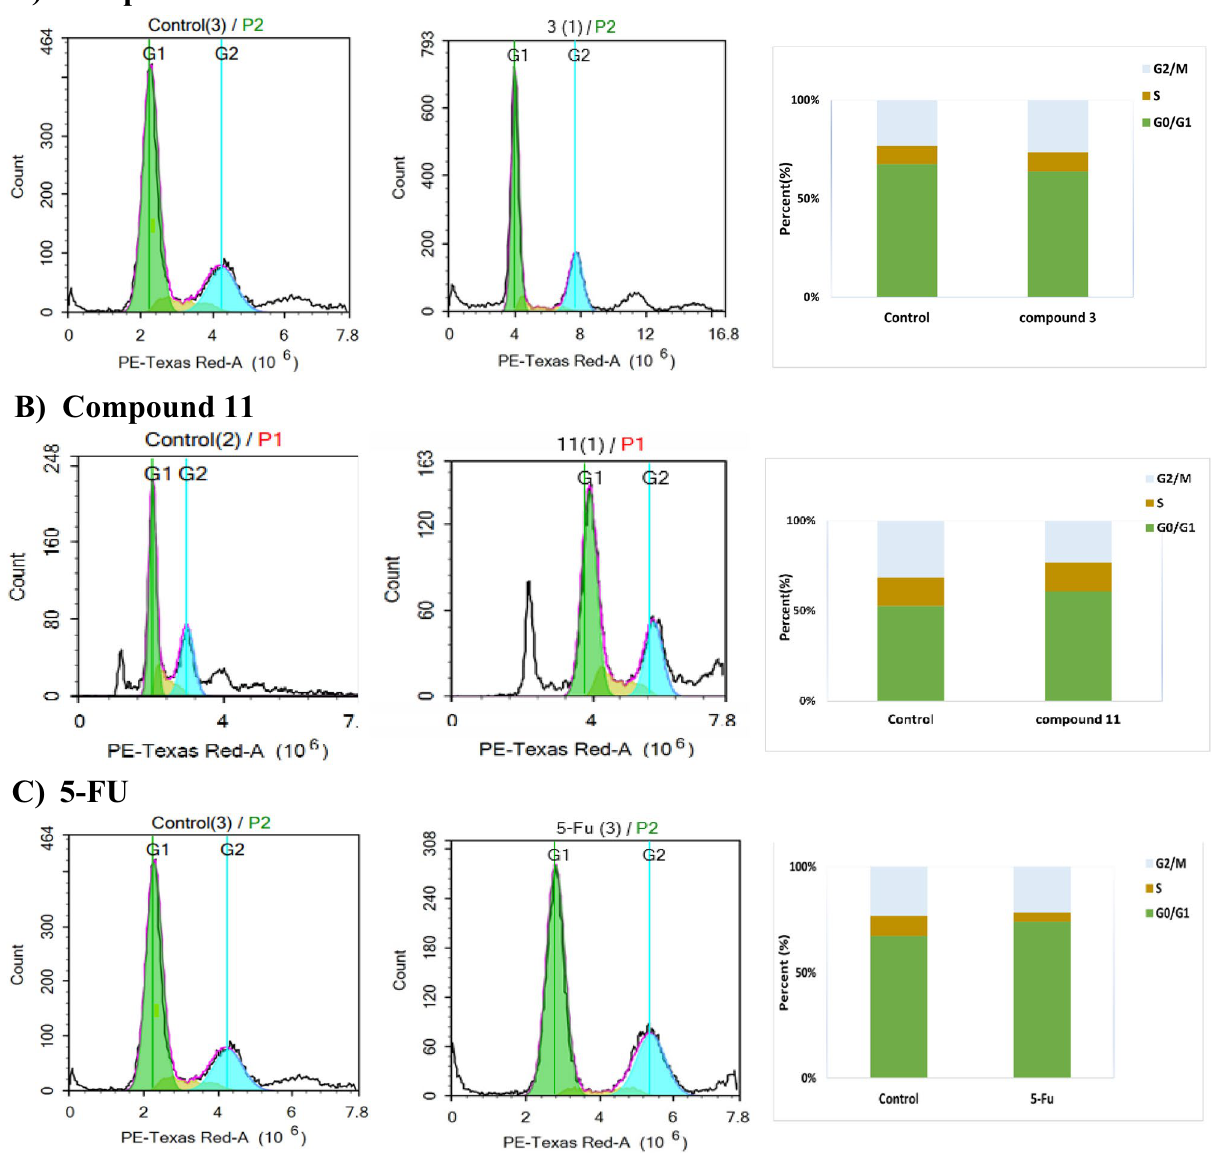
Figure 7. Cell cycle assessment for compounds 3 , 11 and 5-FU on HCT-116 cells; ( A ), ( B ), and ( C ),